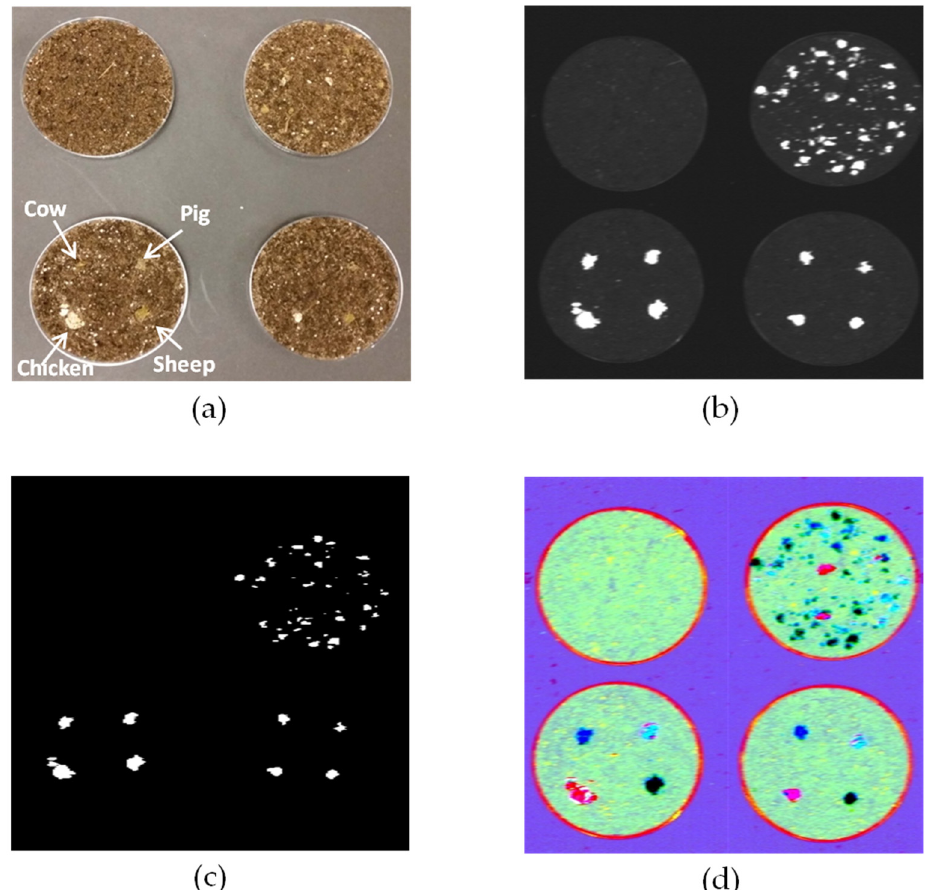
Figure 4. ( a ) Photo of representative feces-soil sample matrix where (in clockwise order from upper left) one Petri dish contains only soil, one Petri dish contains a random mixture of soil and fecal particulates from all animal species, and two Petri dishes (at bottom) each contain soil topped with larger fecal particulates from each of four animal species; ( b ) Fluorescence image of the representative soil-feces sample matrix acquired at 676 nm; ( c ) Binary feces distribution image obtained by applying automated Otsu threshold (Otsu, 1979) to the 676 nm fluorescence image of soil-feces sample matrix; ( d ) RGB color composite image obtained from a combination of PC2, PC3, and PC4 score images of the soil-feces sample matrix.